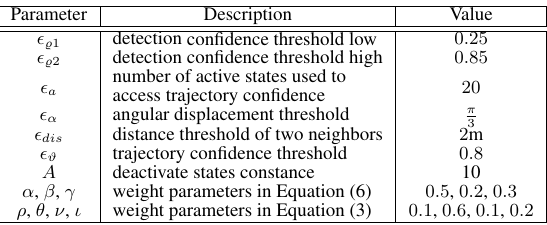
Table 1. Setting of parameters of our tracking system. Figure 6. 2D bounding box prediction and correction. The corrected box (green) tightly covers the deactivated target object (gray).